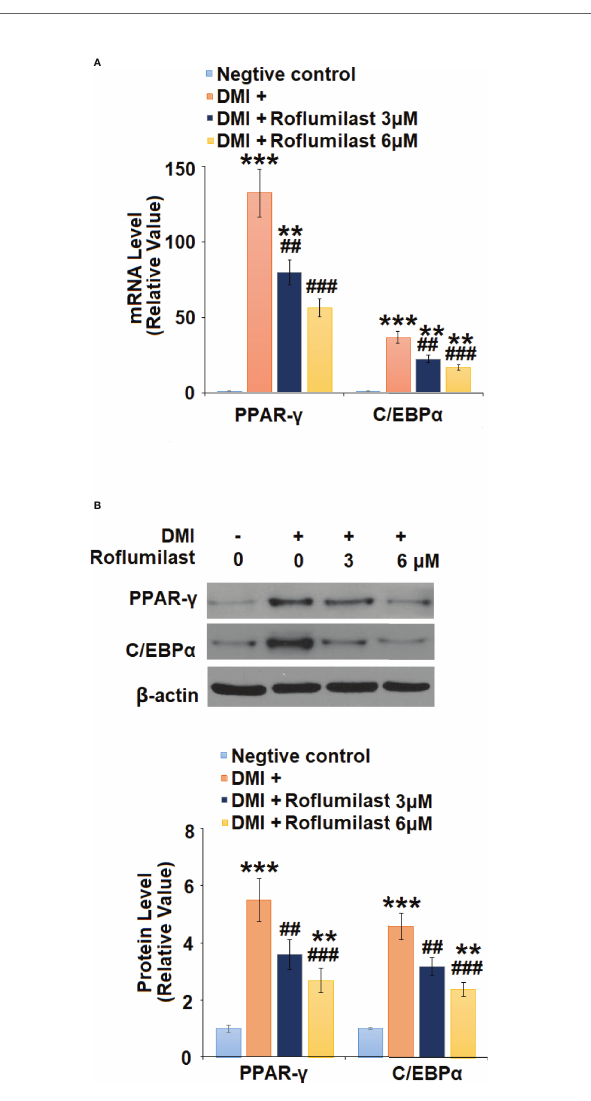
FIGURE 5 | Ro fl umilast regulates adipogenic and lipogenic transcriptional factors. Cells were incubated with a differentiation cocktail (DMI) medium with Ro fl umilast (3 and 6 m M). (A) mRNA of PPAR- g and C/EBP a ; (B) Protein levels of PPAR- g and C/EBP a , and the representative images of each protein were shown on the top panel, the quanti fi cation of protein level was shown on the bottom panel (**, ***, P < 0.05, 0.01, 0.005 vs. vehicle group; ## , ### , P < 0.01, 0.005 vs. DMI group, n =